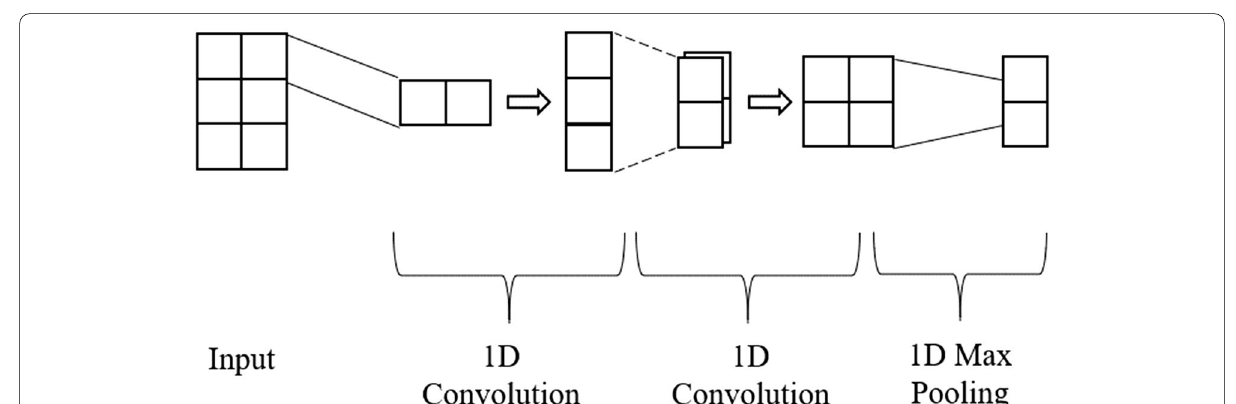
Fig. 4 Diagram illustrating a 2-layer stack 1D convolution network. The first 1D convolution has 1 filter of size 1, generating a 3 - 1 feature map. A second convolution takes the 3 - 1 feature map and applies a 1D convolution with 2 filters of size 2, generating a 2 - 2 feature map. 1D max Pooling is then applied after the second convolution producing a